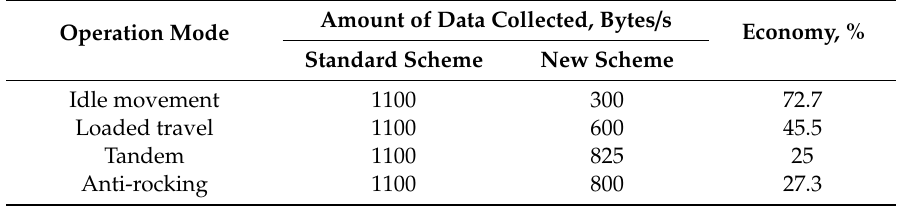
Table 4. Evaluation of the e ff ectiveness of fog nodes for di ff erent operating modes of